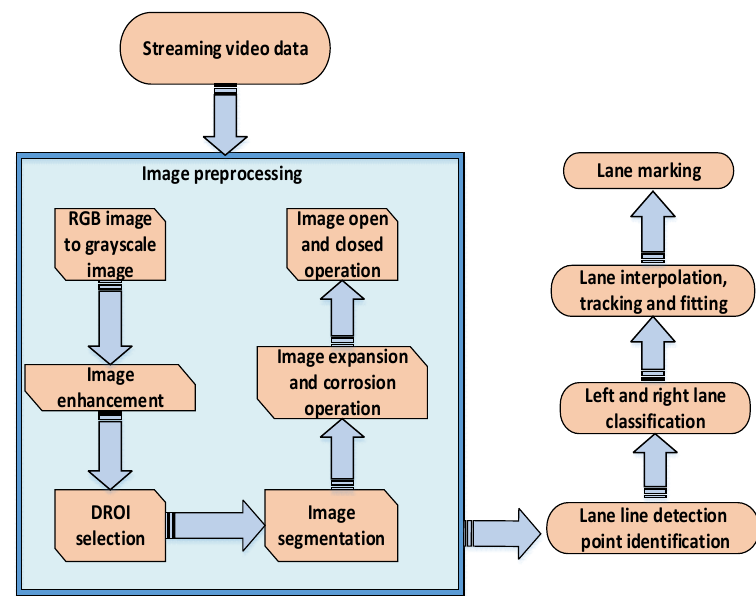
Figure 7. Lane line detection flow chart.